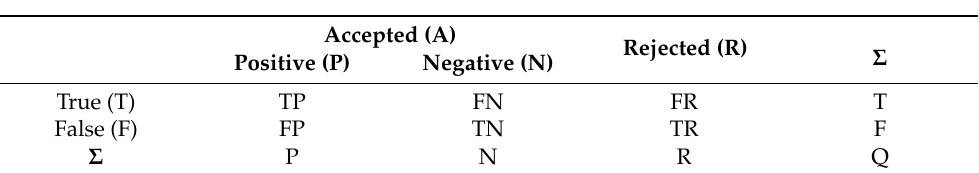
Table 2. Confusion matrix.